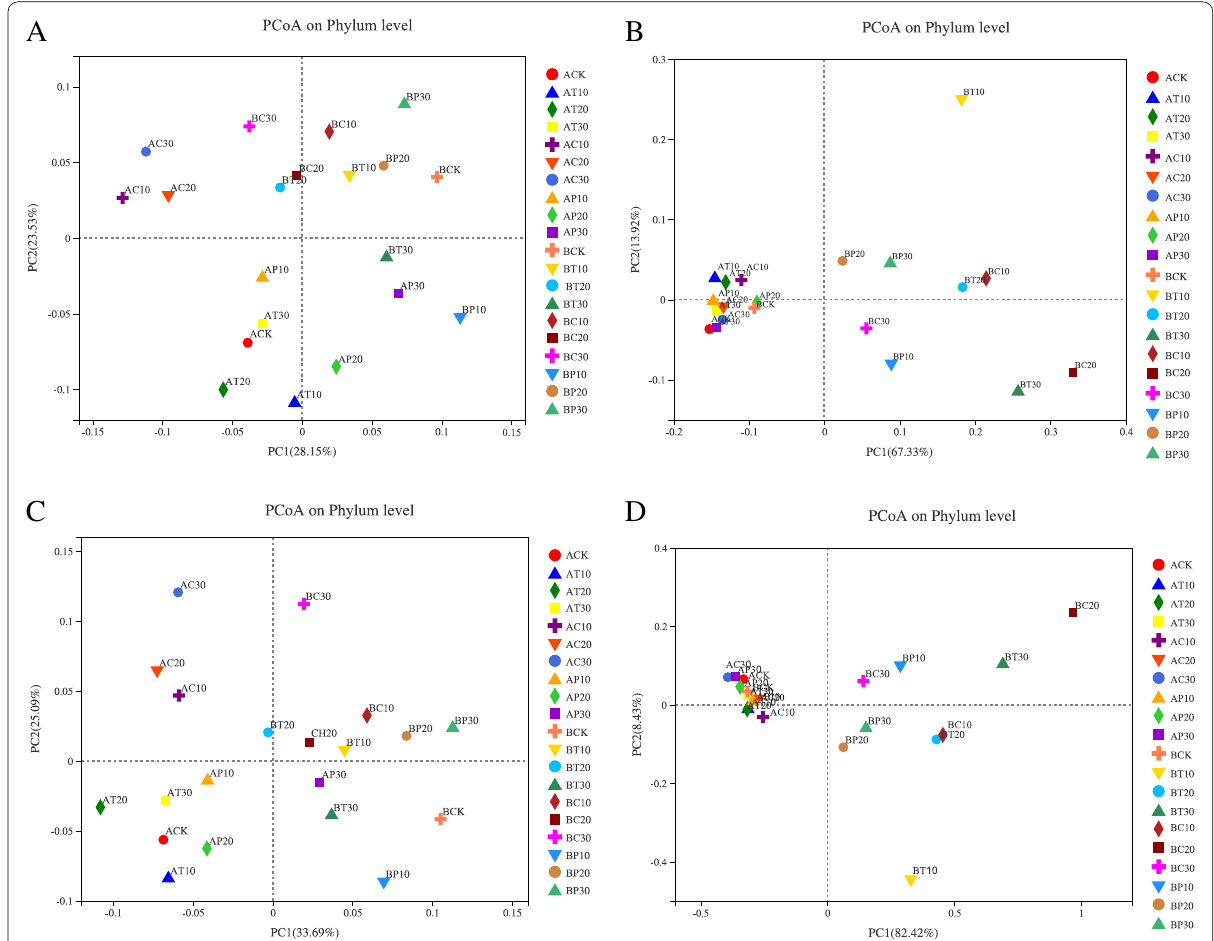
Fig. 2 Principal coordinate analysis of bacterial and fungal communities based on Bray-Curtis similarity distances and weighting of UniFrac distances. A PCoA plots of bacterial communities based on Bray-Curtis similarity distances. B PCoA plots of fungal communities based on Bray-Curtis similarity distances. C PCoA plots of bacterial communities based on weighting of UniFrac distances. D PCoA plots of fungal communities based on weighting of UniFrac distances. PCoA plots based on Bray-Curtis and weighted-UniFrac